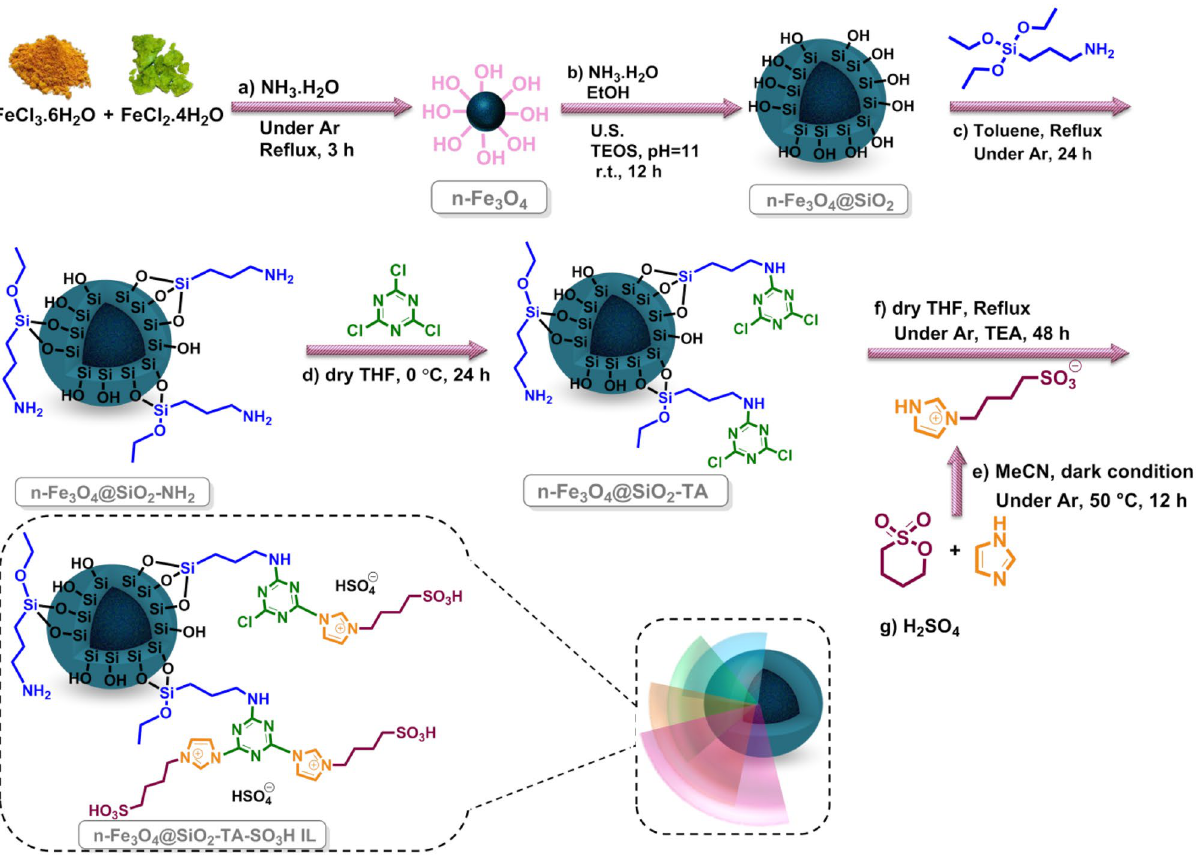
Figure 5. The possible formation process of n-Fe 3 O 4 @SiO 2 -TA-SO 3 H